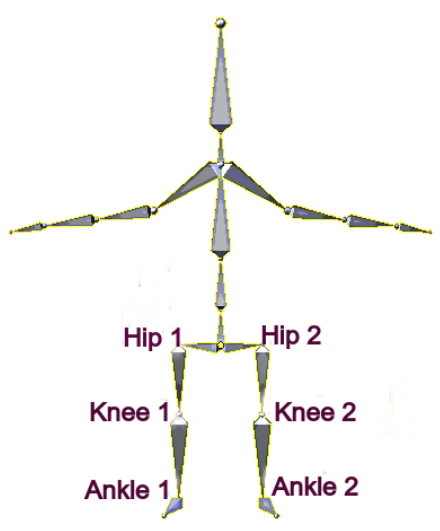
Figure 1. The joints of interest to detect and use in our tracker are at the ankles, knees, and